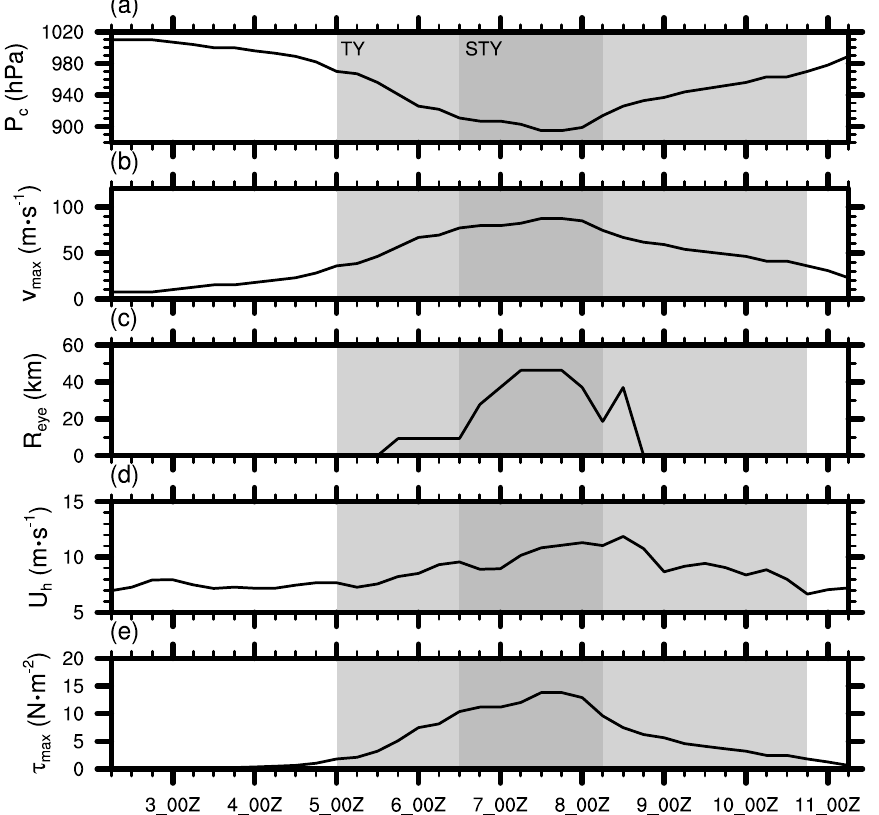
Figure 2. Time series of best-track information of super-typhoon Haiyan, ( a ) central pressure, ( b ) maximum sustain wind speed, ( c ) radius of eye, ( d ) translation speed, and ( e ) wind stress. The light gray shade indicates the time period of typhoon (TY) stage and the deep gray shade represents super-typhoon (STY)